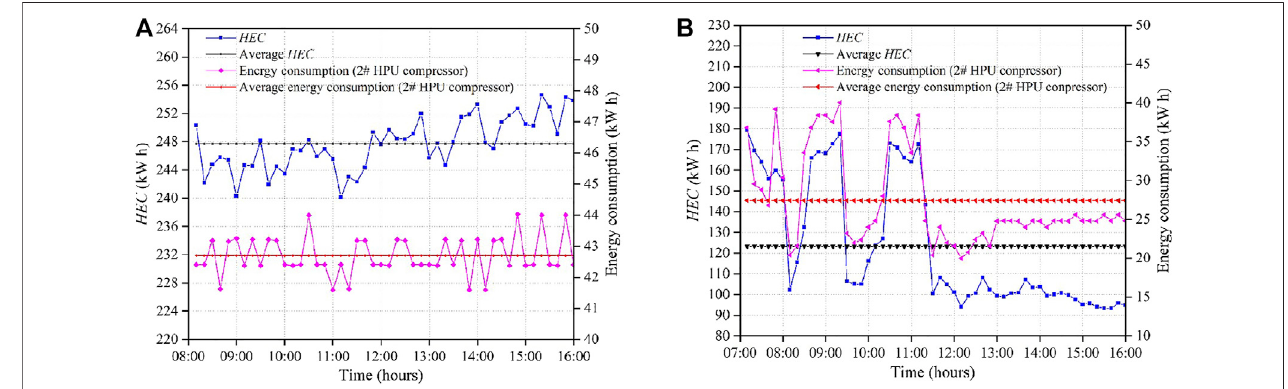
FIGURE 8| HEC of SWC system and energyconsumption as afunction of time during (A) cooling period (July 6, 2017) and (B) heatingperiod (January 20, 2017).